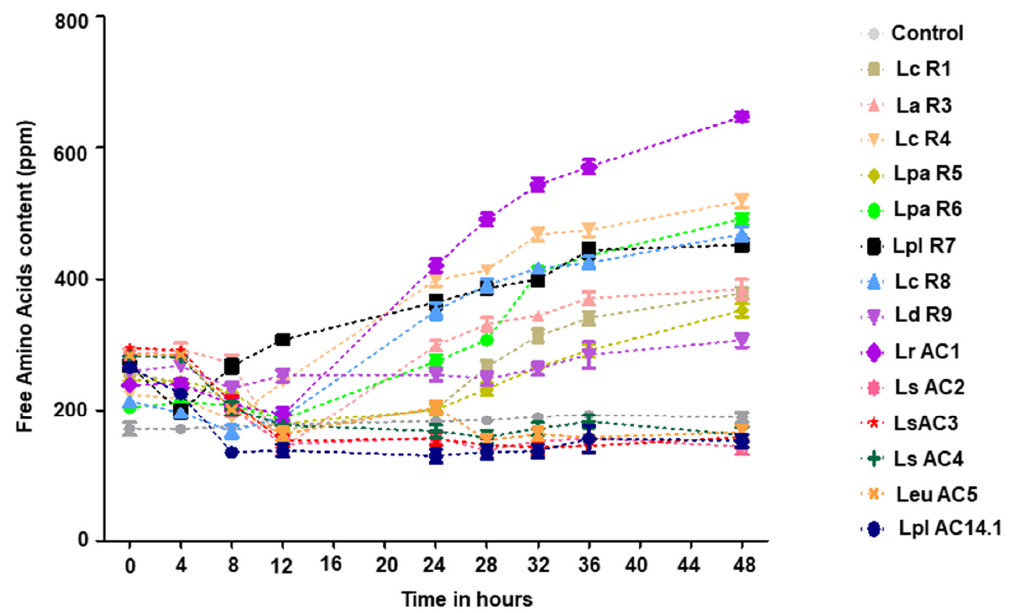
Figure 9. Changes in free amino acid (FAA) content in the soymilk fermented by different LAB isolates at different timepoints during fermentation. n = 2. Lc, L. casei ; La, L. acidophilus ; Lpa, L. paracasei ; Lpl, L. plantarum ; Ld, L. delbrueckii ; Lr, L. rhamnosus ; Ls, L. sakei ; Leu, Leu. mesenteroides. Table 3. Content of main isoflavone forms, genistein and daidzein, in the soymilk fermented by LAB isolates after 48 h.